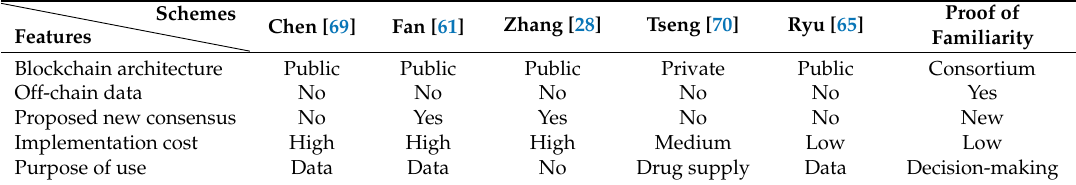
Table 3. Comparison of blockchain-based medical and healthcare